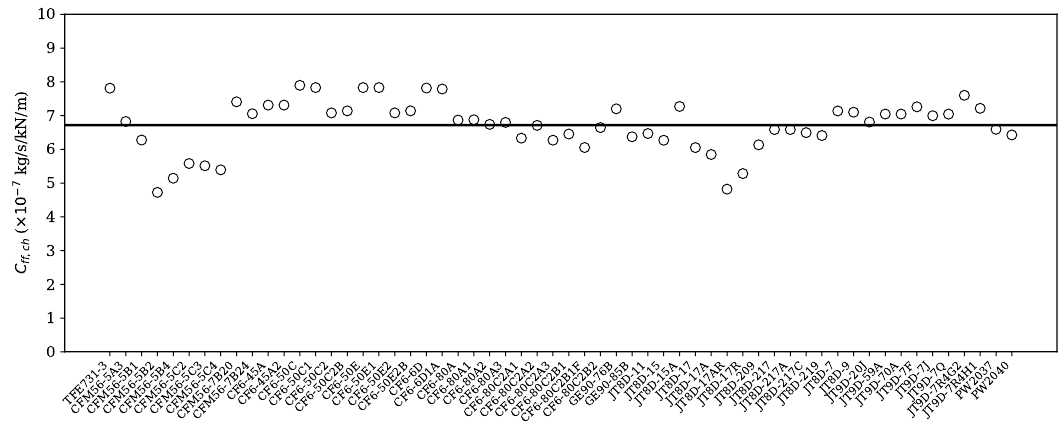
Figure 6. Difference in specific fuel consumption at sea level and cruise